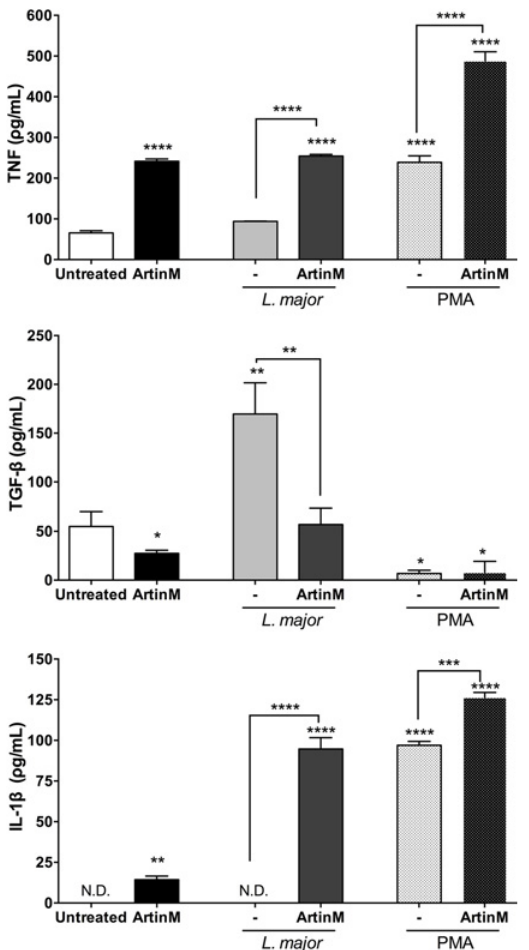
Fig 2. ArtinM stimulates the production of inflammatory cytokines by L . major -infected or uninfected neutrophils. Human neutrophils were treated with or without ArtinM or PMA, and either infected or not infected with L . major promastigotes (MOI 3:1). At 20 h post-infection, the supernatant of these cells was collected for cytokine measurement by ELISA. A – TNF, B – TGF β -1 and C – IL-1 β concentrations are expressed as mean ± SD. * p < 0.05; **** p < 0.001 in comparison to untreated cells, or as indicated. One way ANOVA followed by Bonferroni's post-test. ND stands for “ not detected ” . ELISA assays were carried out in triplicate. The shown data are representative from three different